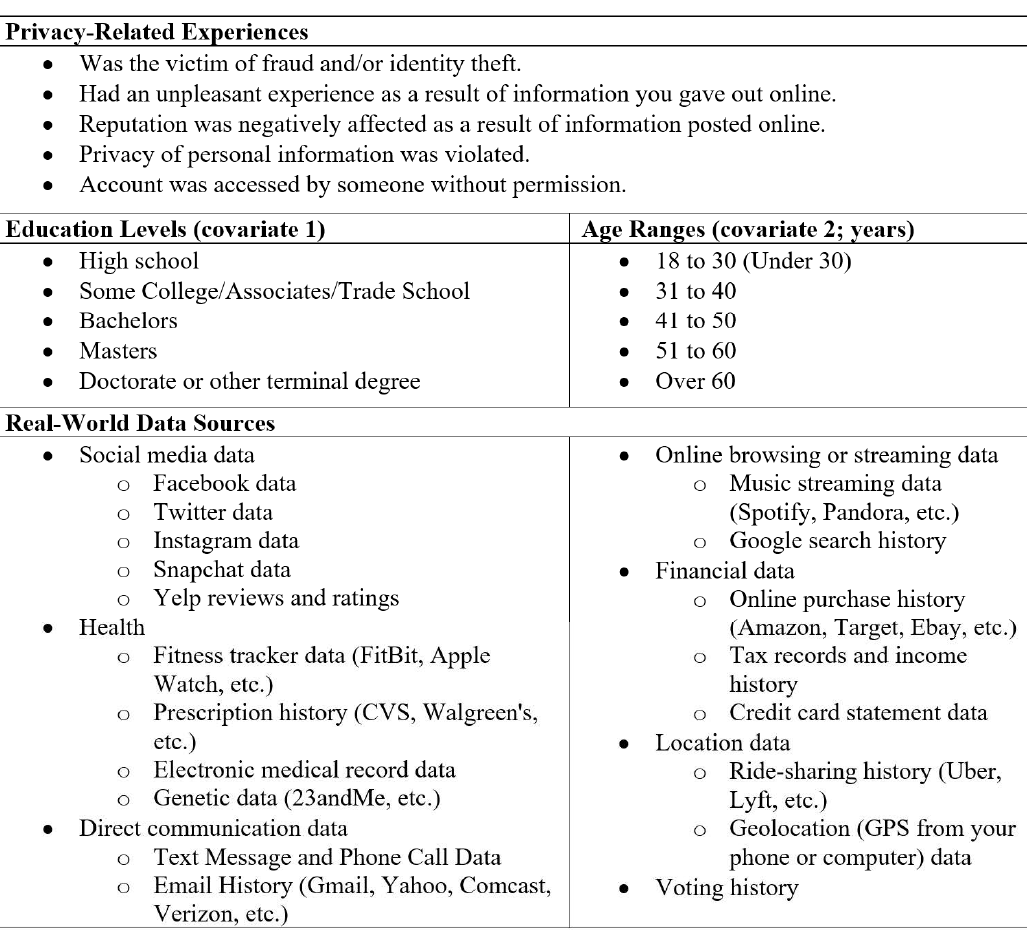
Figure 2. List of privacy-related experiences, age ranges, and education levels and real-world data sources.